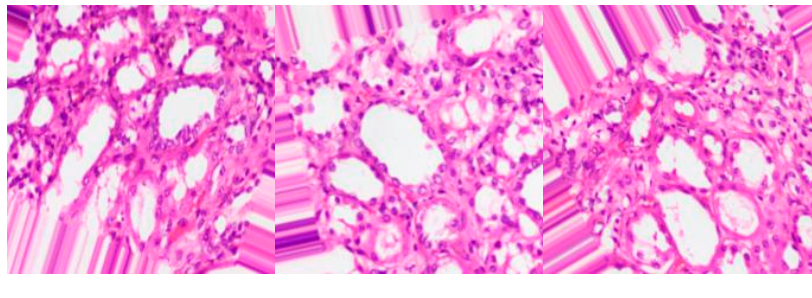
Figure 3. Data samples from grade 0, grade 1, and grade 2 classes. 5. Simulation and Results In this article, IoMT-based deep learning techniques empowered with transfer learn- ing and blockchain security were used to predict kidney cancer in its early stages for better therapy. MATLAB 2021 was used for simulation purposes. For training and testing simu- lation purposes, a MacBook Pro 2017 with 16GB RAM and 512GBSSD was used for the proposed framework. The proposed model used a dataset in two parts: training and test- ing of 70% and 30%, respectively. In the data preprocessing stage, the proposed frame- work applied data augmentation techniques to balance the data in all predicted classes